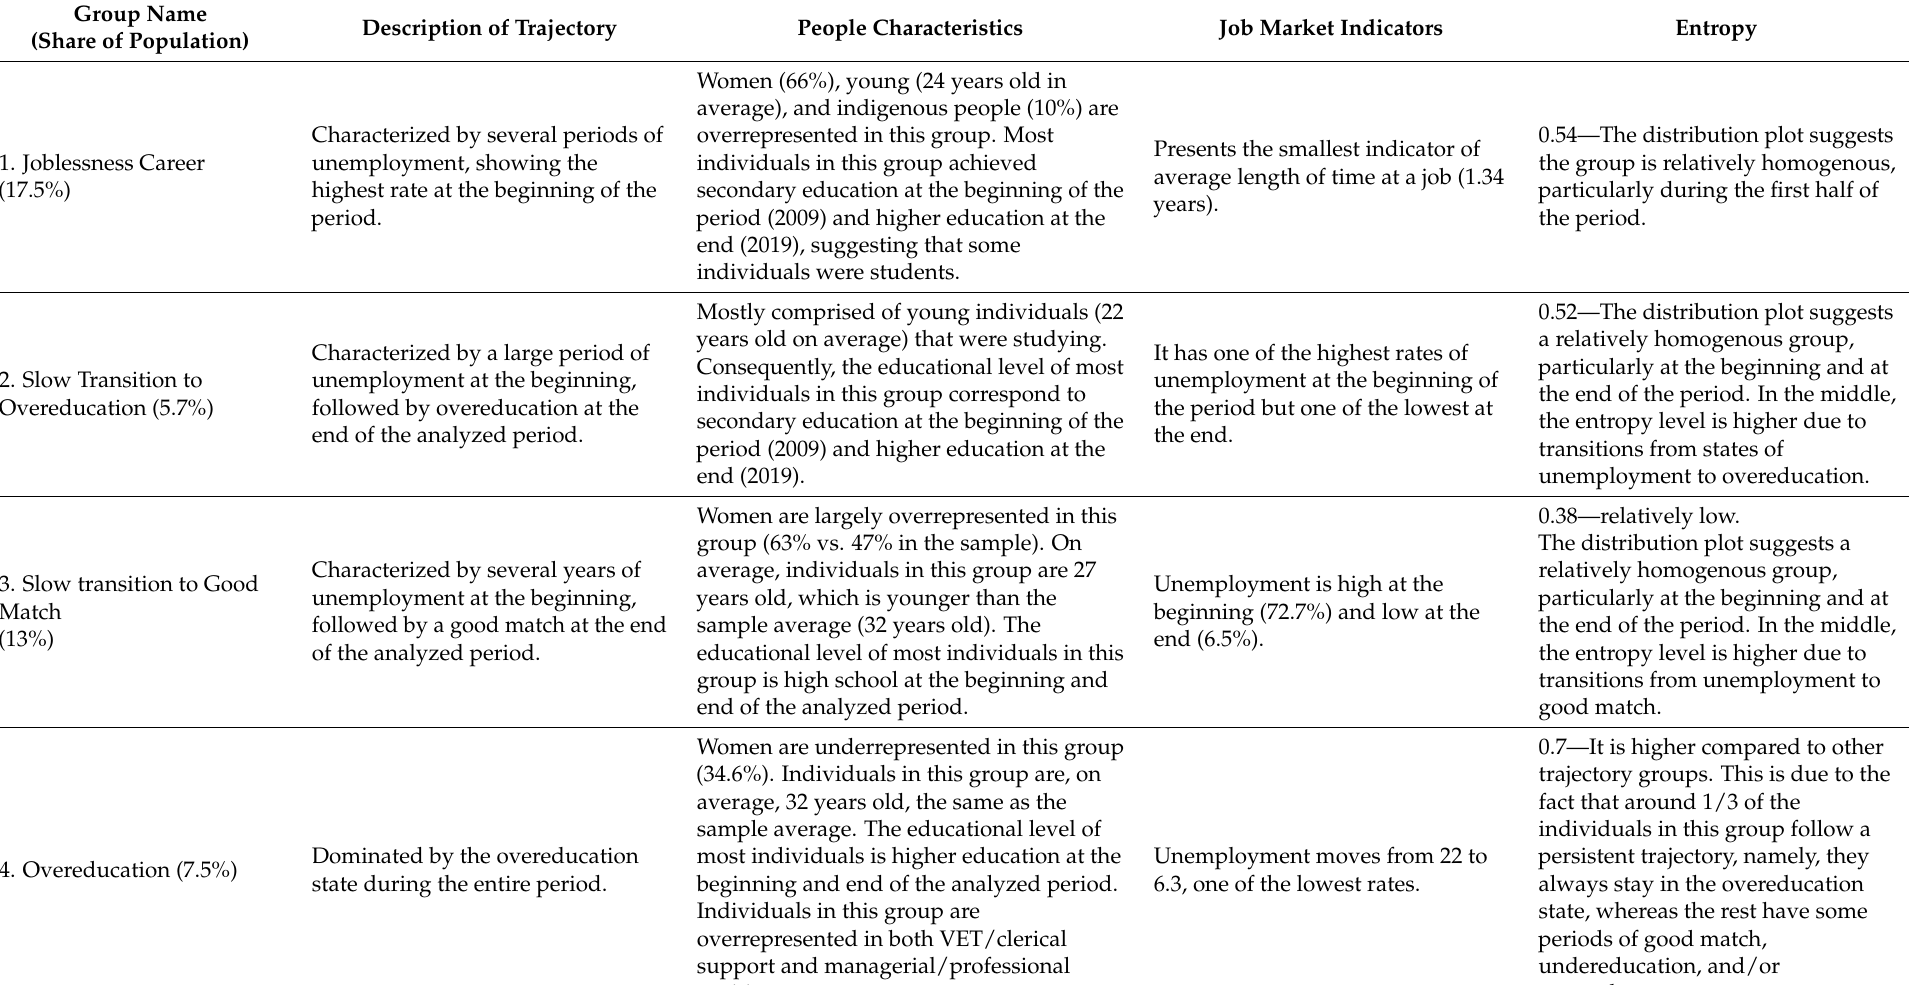
Table 1. Description of educational mismatch trajectory patterns,